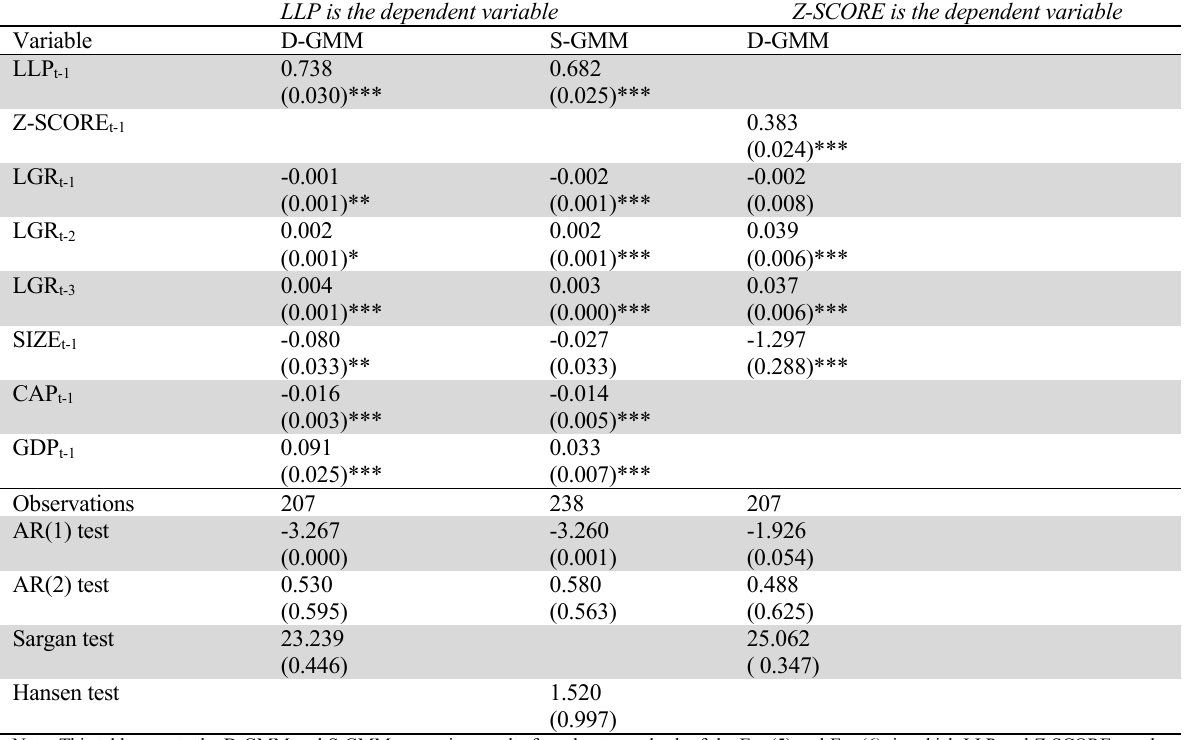
Robustness checks of regression